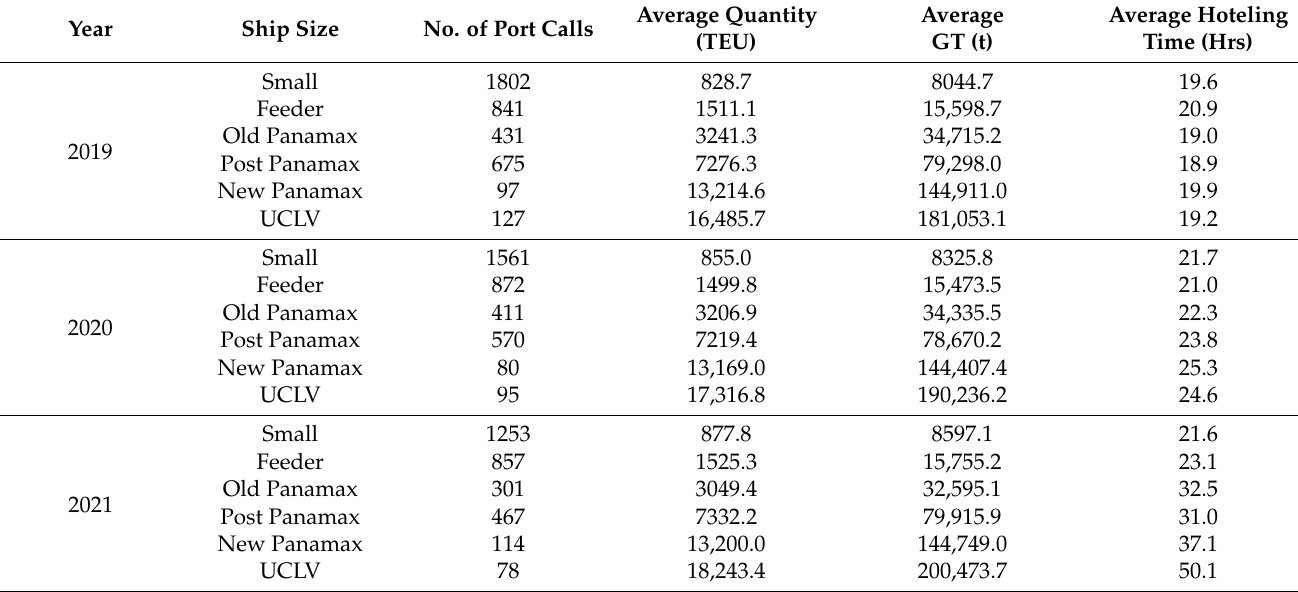
Table 1. Data on ships at berth equipped with shore power facilities in the Port of Busan (adapted from Port-MIS)